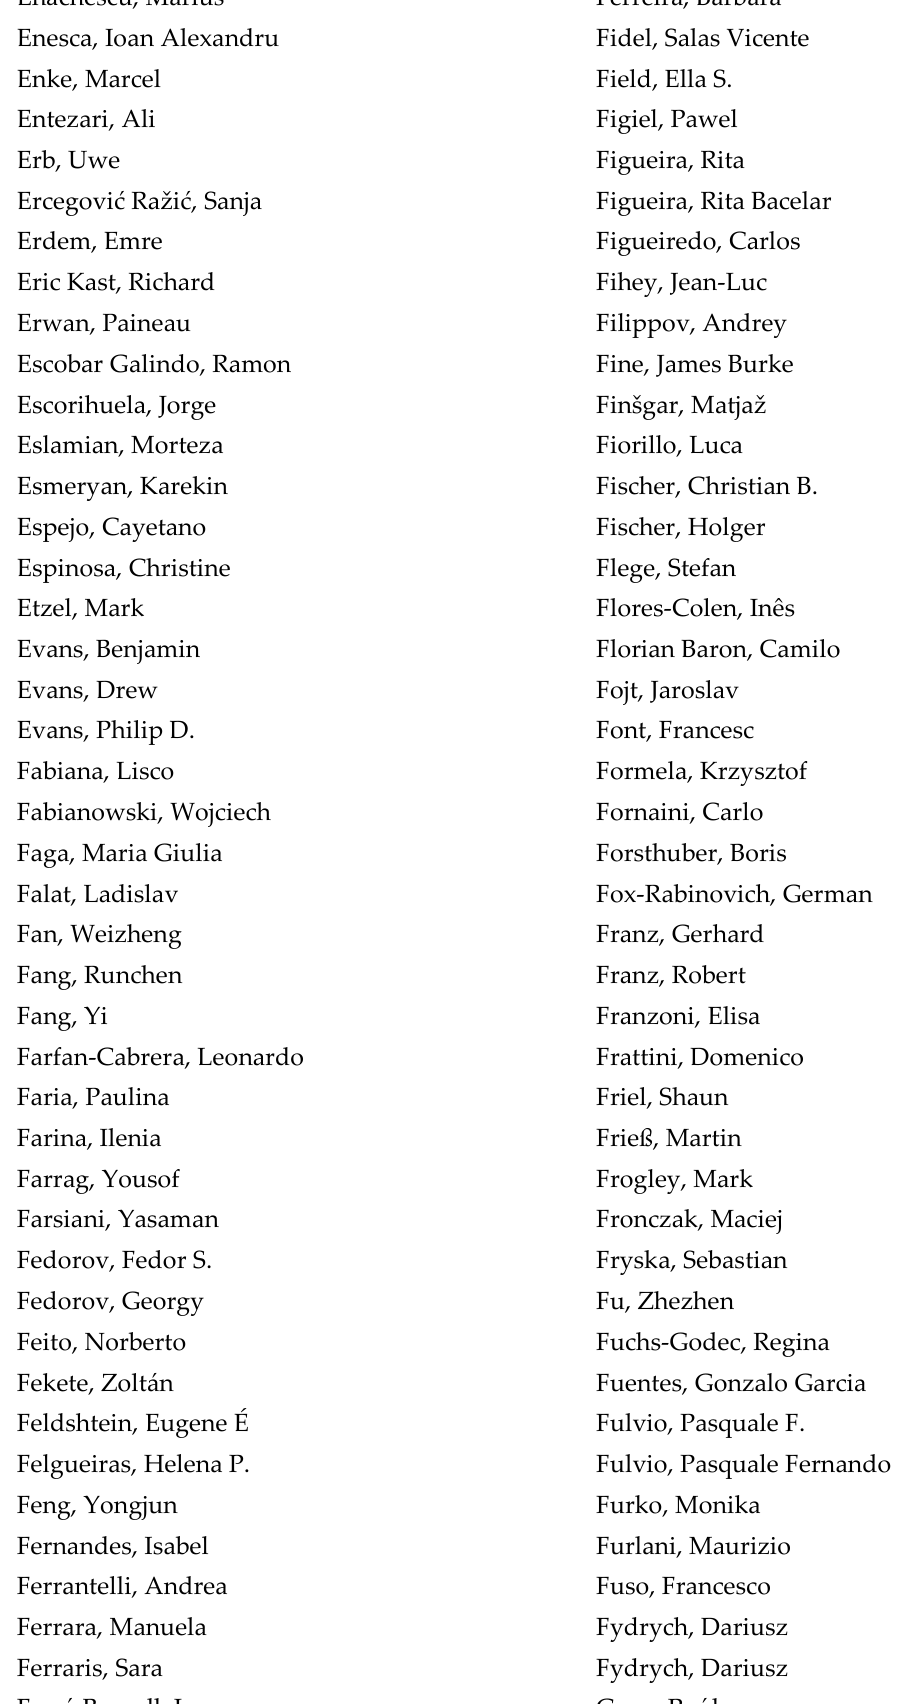
Figiel, Pawel Figueira, Rita Figueira, Rita Bacelar Figueiredo,